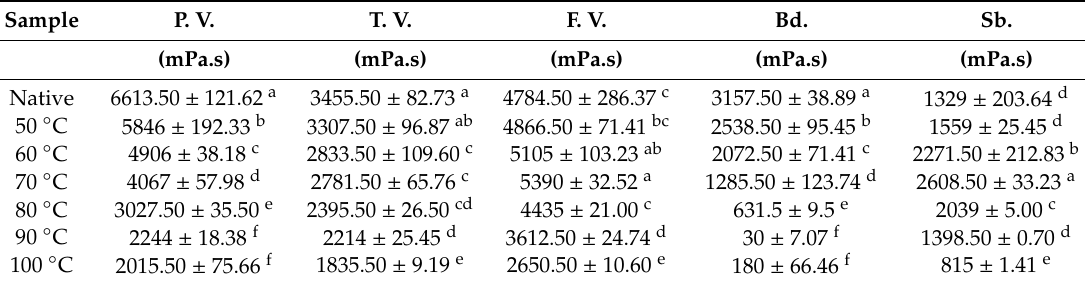
Table 2. Pasting profiles of controlled gelatinized mung bean starch.